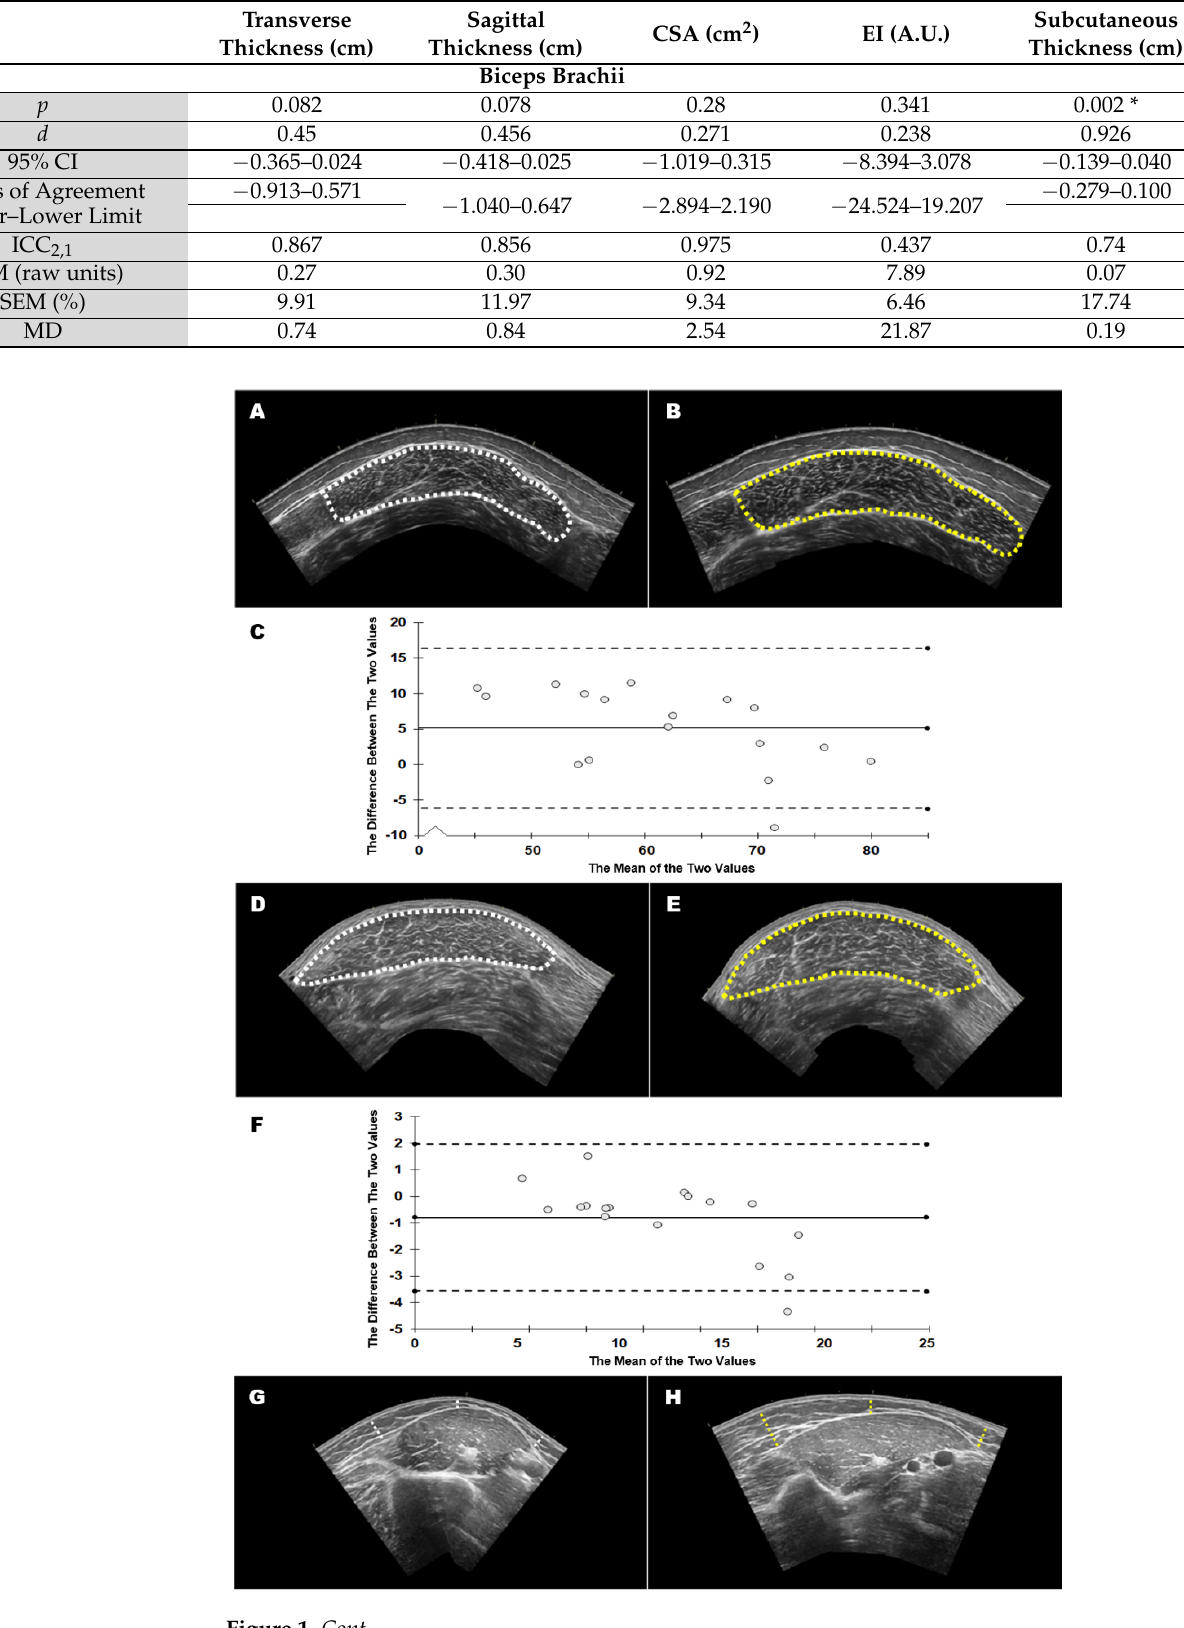
Figure 1. Acquired images from the experienced sonographer (left column, A , D , G ) and the novice sonographer (right column, B , E , H ) were analyzed by the experienced analyst (G.G.). The variables that were significantly different between sonographers during acquisition are shown: echo intensity of the vastus lateralis (top row, A , B ), cross sectional area of the medial gastrocnemius (middle row, D , E ), and subcutaneous adipose tissue thickness of the biceps brachii (bottom row, G , H ). Bland Altman plots are shown for each variable ( C , F , I ). Dotted lines: 95% limits of agreement.